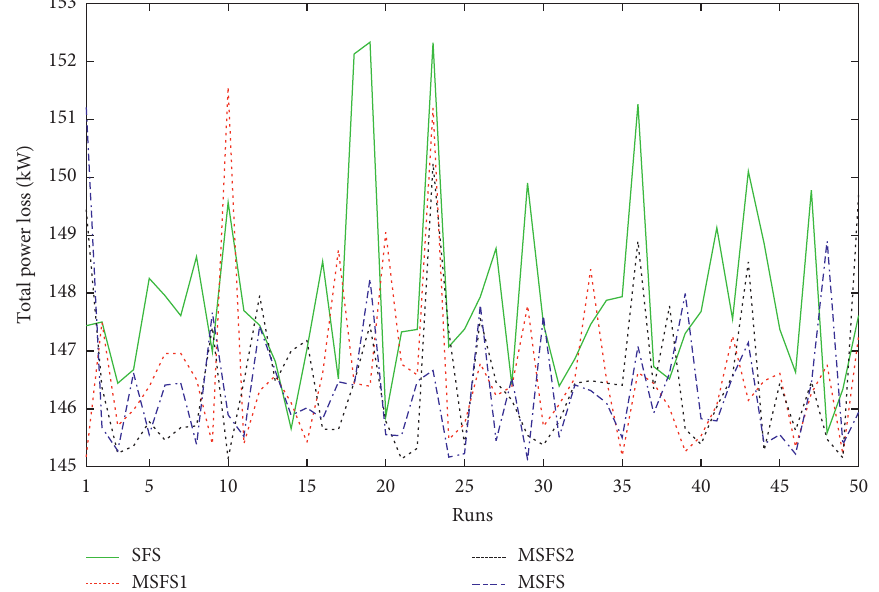
Figure 16: Total power loss of 50 trial runs obtained by SFS methods for case 2 of the 69-bus